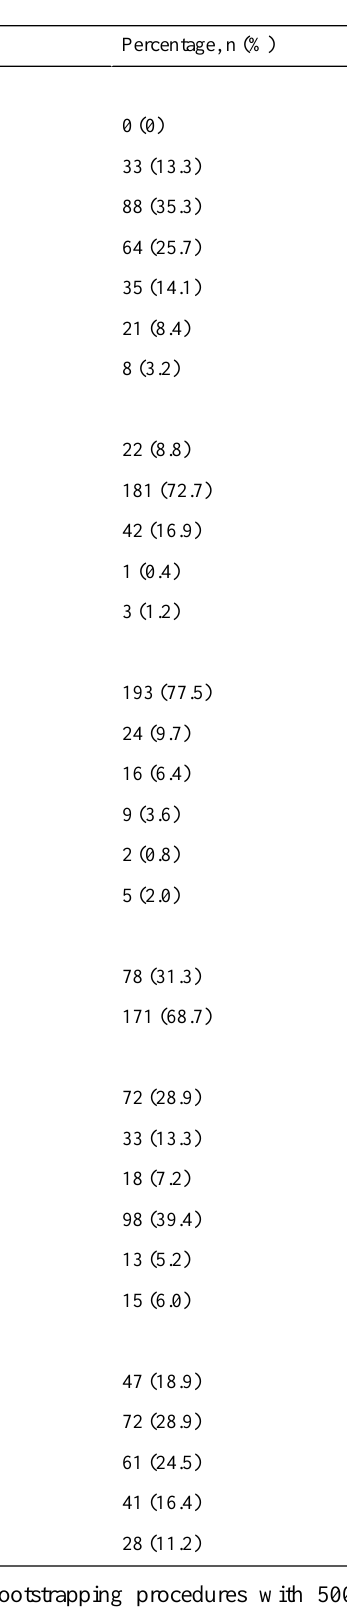
Table 4. Key demographics of caregivers